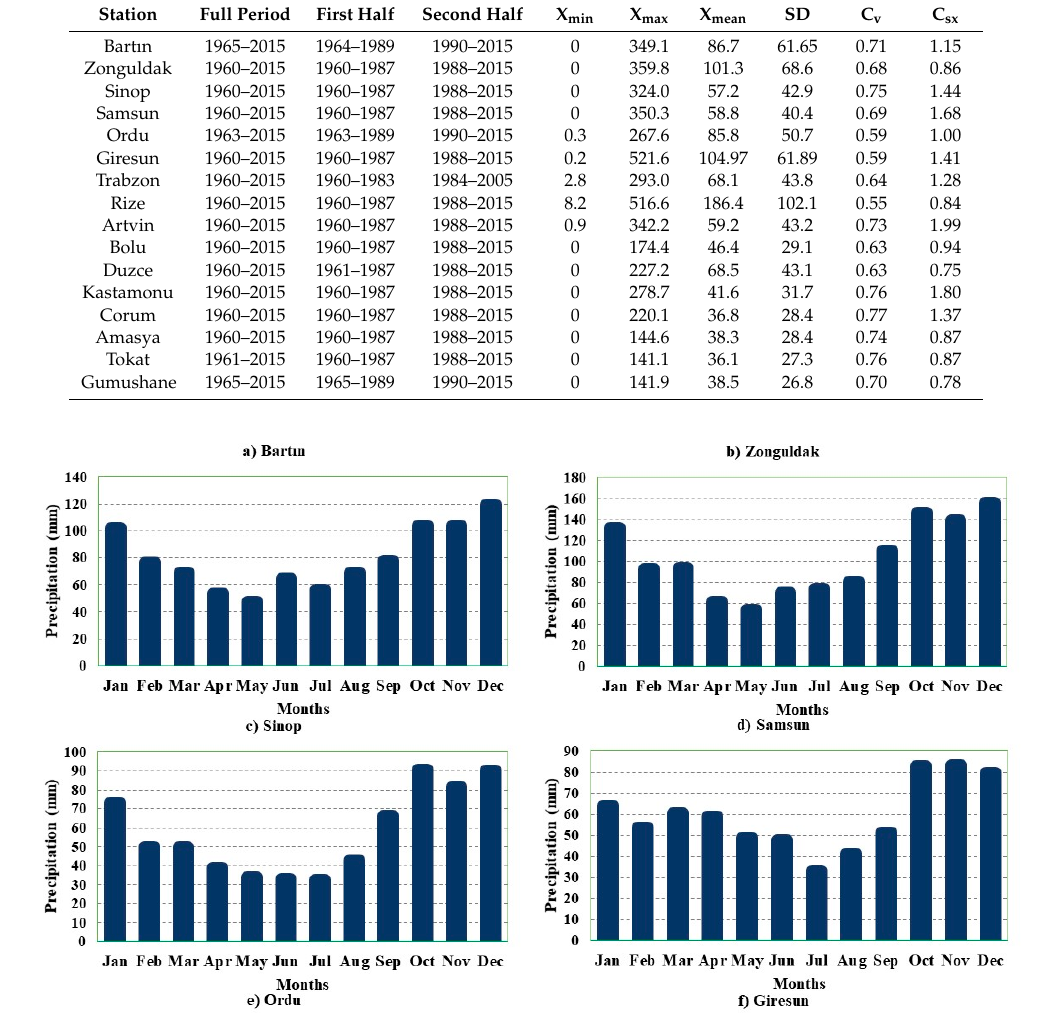
Table 1. Statistical information of monthly rainfall data and the record length at the observation stations (X min , X max and X mean : minimum, maximum and mean monthly precipitation; SD: standard deviation; C v : coe ffi cient of variation; C sx : coe ffi cient of